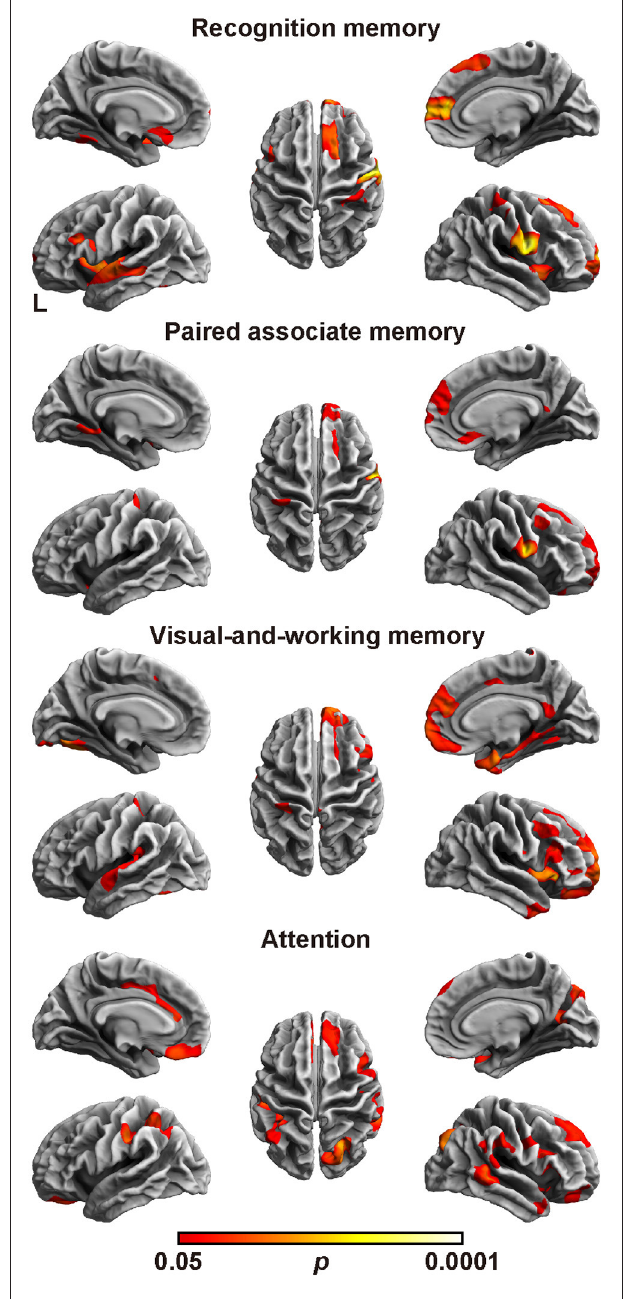
FIGURE 2 | Brain regions with a positive correlation between cortical fractal detention and factor scores. The threshold was set at p < 0.05 (TFCE-corrected permutation test). See Table 6 for the details of the regions. L,